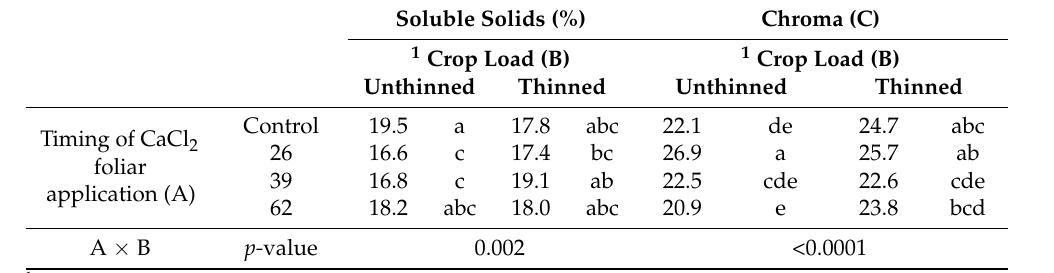
1 Means of 20 fruits/replicate. Different letters in the same column indicate significant differences between the timing of CaCl 2 foliar applications (A) based on Tukey’s test ( p ≤ 0.05) or between crop load levels (B) based on ANOVA ( p ≤ 0.05). Control with water only. 2 Timing of CaCl 2 foliar application (TFA) and Crop Load (CL). Highly significant interactions between the timing of foliar CaCl 2 application and crop load were observed for SSC ( p = 0.0021) and Chroma color ( p < 0.0001) but with no clear trend or visual difference (Table 5). The lowest SSC and the highest chroma values were observed in fruit from unthinned trees after a foliar CaCl 2 spray during Stage I of fruit development. Table 5. Fruit quality in the sweet cherry combination ‘Lapins’/‘Colt’ at harvest, 90 days after full bloom (DAFB), was significantly affected by the timing of foliar CaCl 2 applications (a water control or a CaCl 2 spray at 26, 39, or 62 DAFB) and by crop load (natural unthinned vs. 50% thinned 31 DAFB). There were significant effects on SSC and Chroma at harvest and significant interactions between the timing of the foliar CaCl 2 applications and crop load.